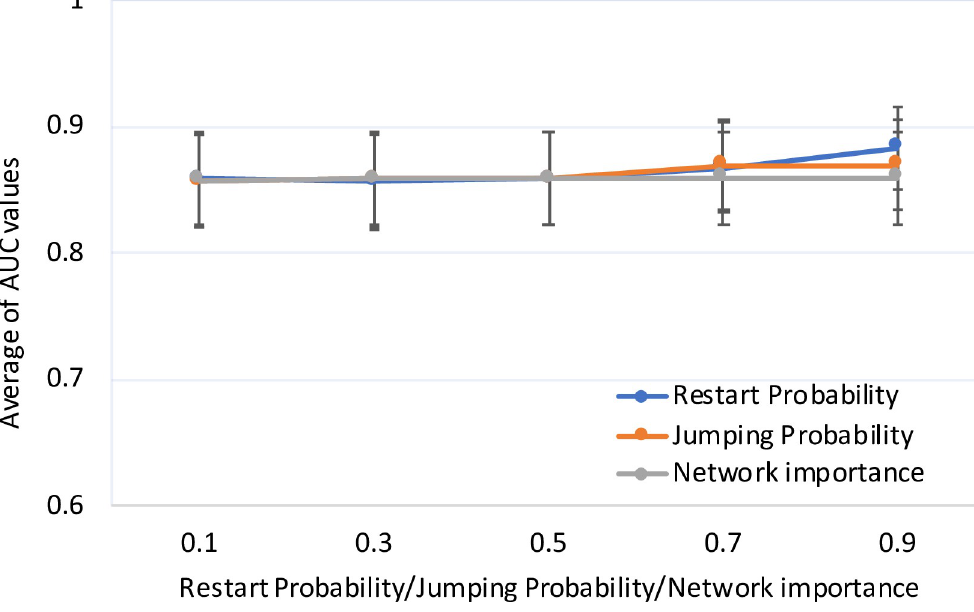
Fig 2. Prediction performance of RWDisEnh on the heterogeneous network of diseases and enhancers with different parameter settings. Restart Probability: λ = η = 0.5, and γ in {0.1, 0.3, 0.5, 0.7, 0.9}. Network importance: λ = γ = 0.5, and η in {0.1, 0.3, 0.5, 0.7, 0.9}; and Jumping Probability: η = γ = 0.5, and λ in {0.1, 0.3, 0.5, 0.7, 0.9}. Average AUC values and standard errors were calculated based on the set of diseases for each data